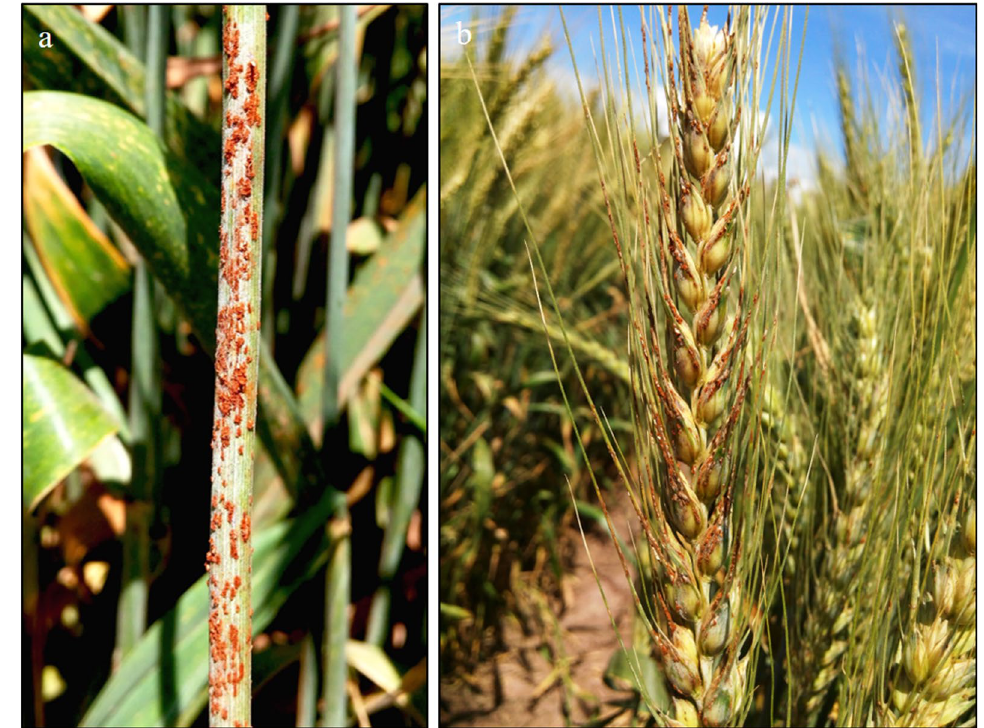
Fig. 3 Symptoms of stem rust in wheat fields. a Uredia on a diseased stem. b Uredia on awns and glumes of a wheat